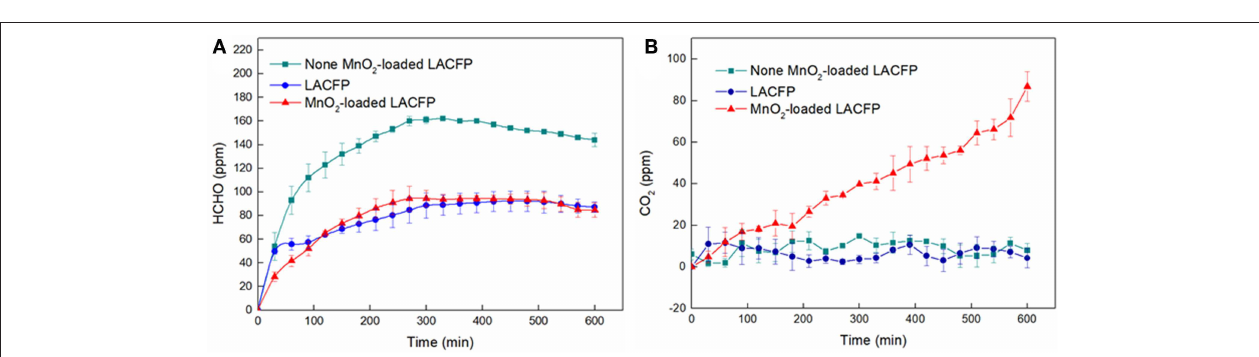
FIGURE 9 | Concentration variation of formaldehyde (A) and 1 CO 2 (B) for none a , LACFP, and MnO 2 -loaded LACFP ( a None denotes only formaldehyde solution without other